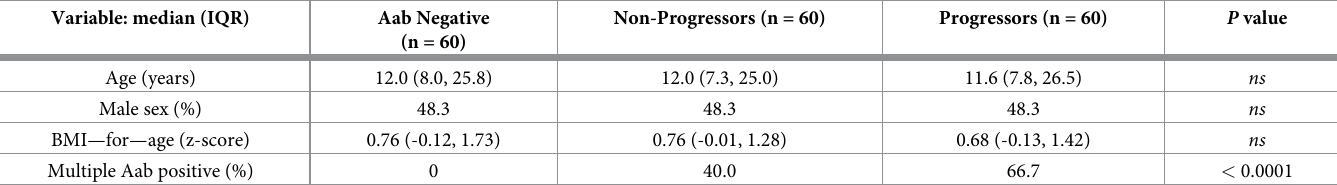
Table 1. Baseline Characteristics of Study Participants.